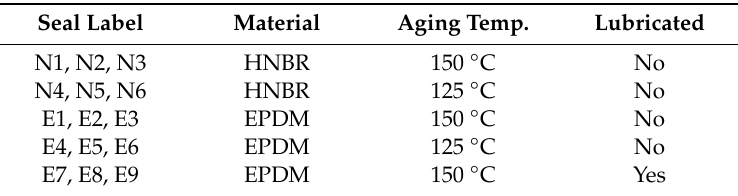
Table 1. Overview of seal nomenclature.